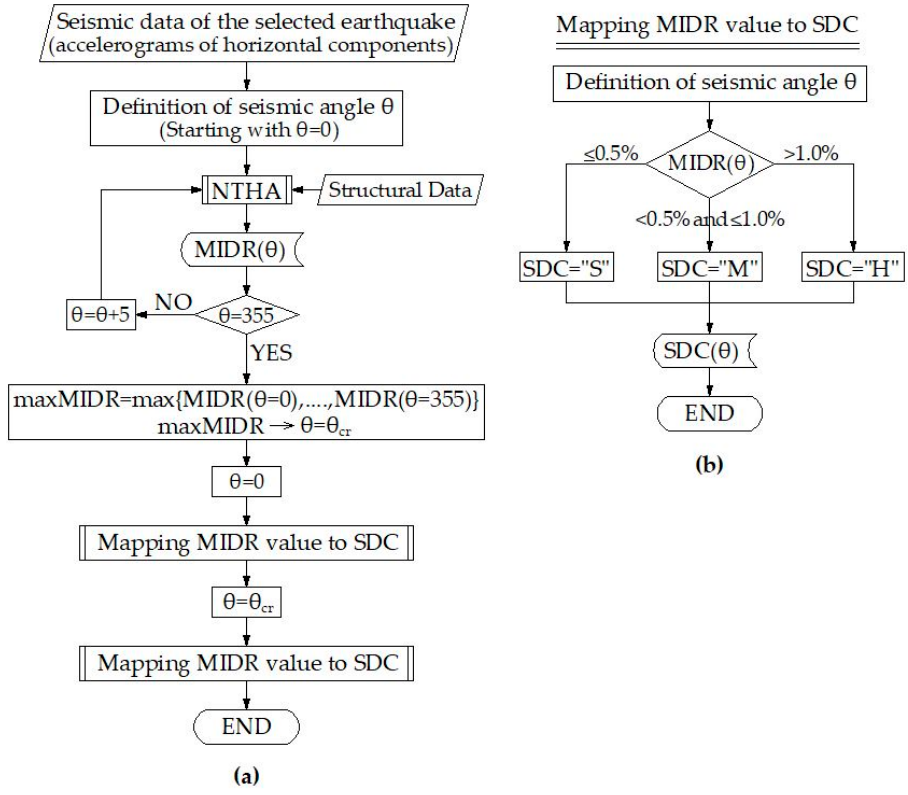
Figure 4. Flowchart of the procedure used for the generation of the training datasets( a , b